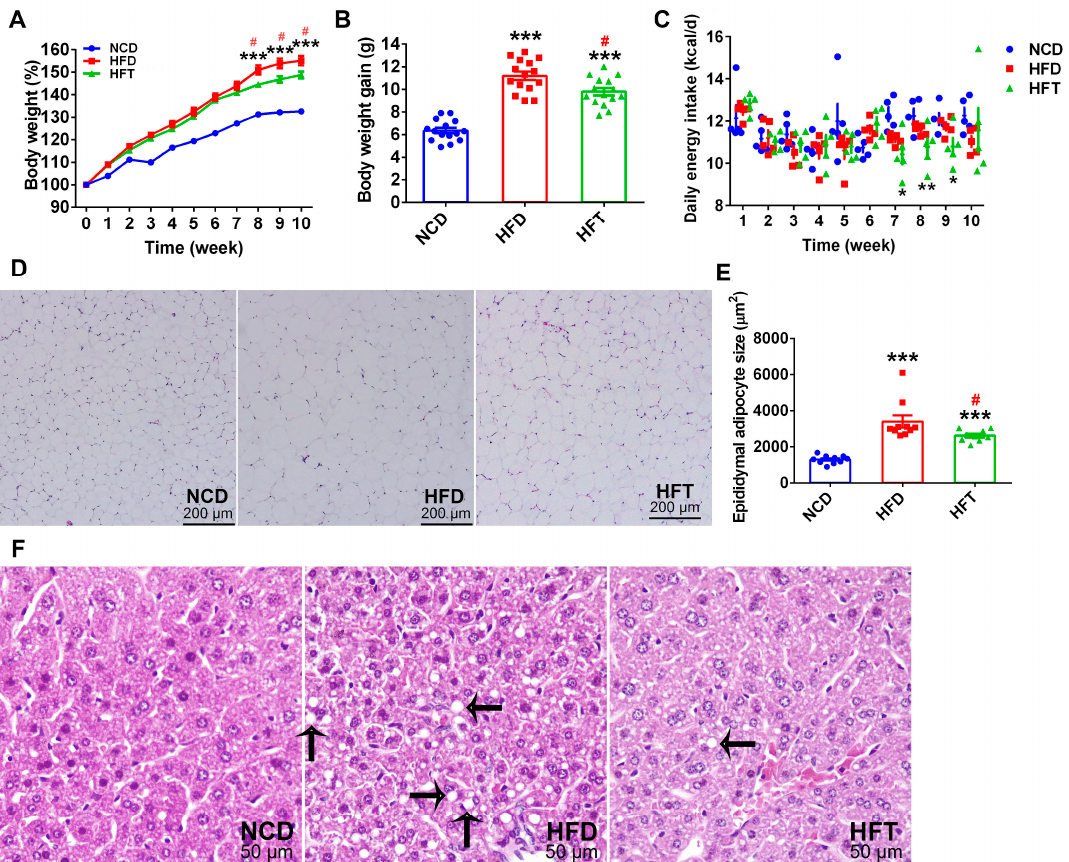
Figure 1. T17 administration suppressed body weight gain and lipid accumulation induced by high-fat diet (HFD). ( A ) body weight changes in 10 weeks, ( B ) body weight gain in the 10 weeks, ( C ) average daily energy intake per cage of the three groups in 10 weeks, ( D ) the H&E staining image of epididymal adipose tissue sections, ( E ) the sizes of stained epididymal adipocytes in the three groups, ( F ) hepatic lipid accumulation revealed by H&E staining and indicated with arrows. Data are expressed as mean ± SEM. Values marked with * are significantly different compared with the normal chow diet (NCD) group and values marked with # are significantly different compared with HFD group (* p < 0.05, ** p < 0.01, *** p < 0.001, # p < 0.05). Table 2. The effects of T17 on the weight of organs and adipose tissue in male C57BL/6 mice. Organs and tissues